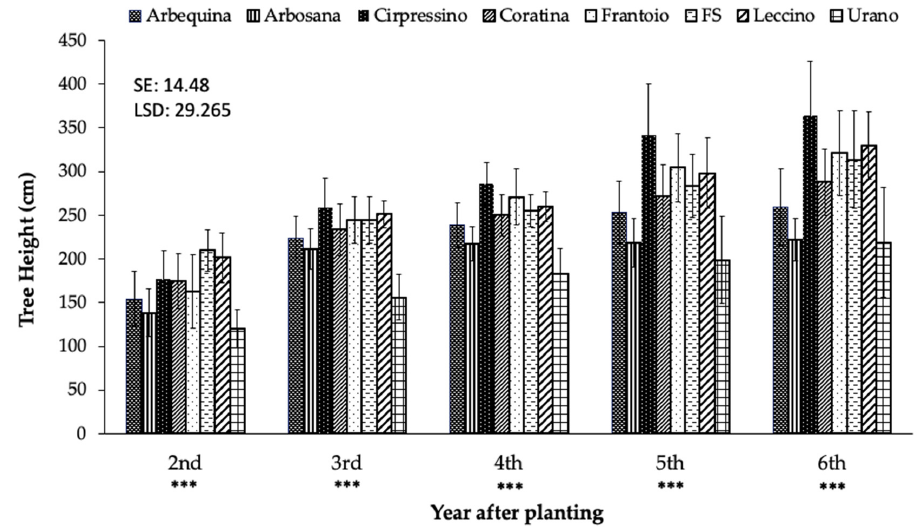
Figure 1. Effect of cultivar on tree height (H, cm) for each year. Standard error (SE) of the mean difference and least significant difference ( p < 0.001) are reported. Bars in each column indicate the standard deviation. *** means p < 0.001.